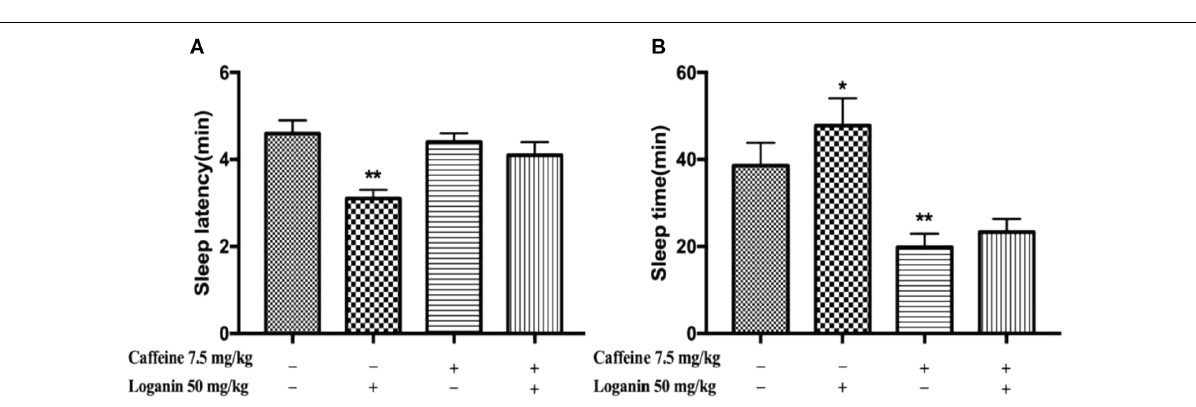
FIGURE 5 | Effects of loganin on caffeine-induced insomnia in pentobarbital-treated mice. The sleep latency (A) and sleep time (B) were assessed. Data are presented as mean ± SEM ( n = 10). ∗ P < 0.05, ∗∗ P < 0.01, vs. vehicle (one-way ANOVA followed by Student-Newman-Keuls